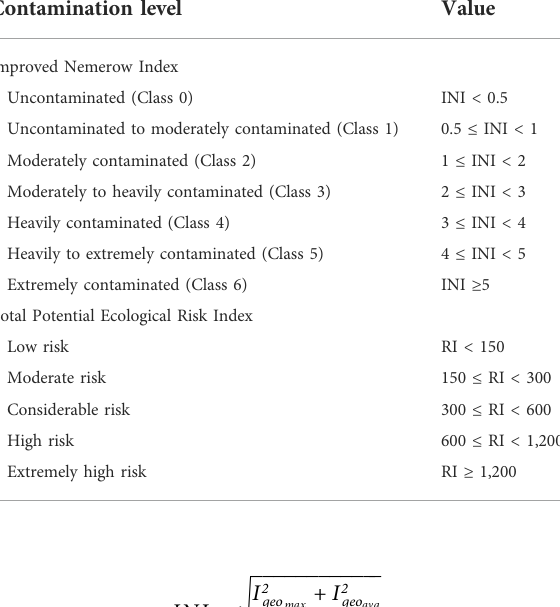
TABLE 2 The Improved Nemerow Index (INI) and Total Potential Ecological Risk Index have a similar association between value and classi fi cation level